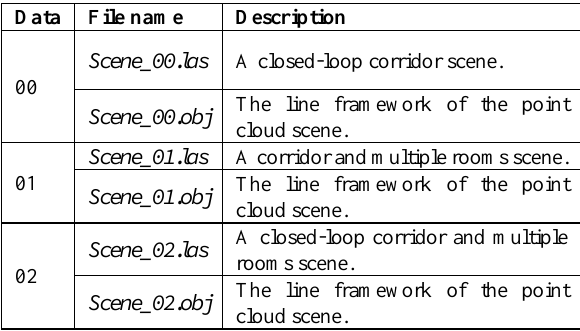
Figure 6. Structure of the BIM feature extraction dataset. Table 2. Data description of the BIM feature extraction